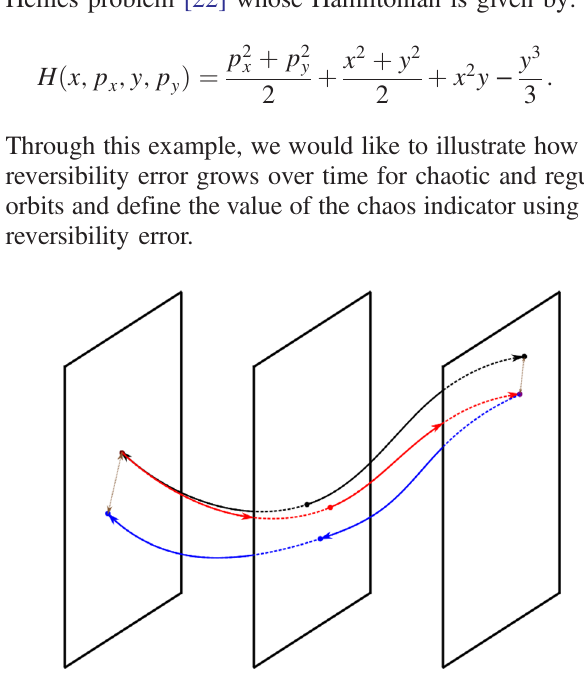
FIG. 1. Illustration of forward-backward integration. The planes represent the phase-space at different integration steps. The black curve is the exact orbit, the red curve is the orbit obtained using numerical integration forward in time, and the blue curve is the orbit obtained using numerical integration backward in